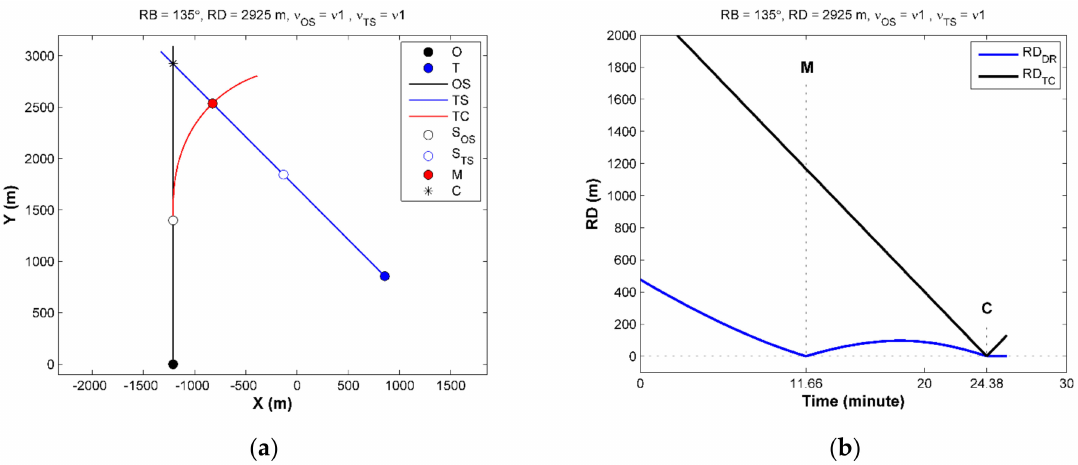
Figure 11. Estimation results for Scenario 4 (encountering angle of 135): ( a ) OS-TS encounter and collision points; ( b ) Estimation of the OS-TS relative distance and the time at collision Points C and M over